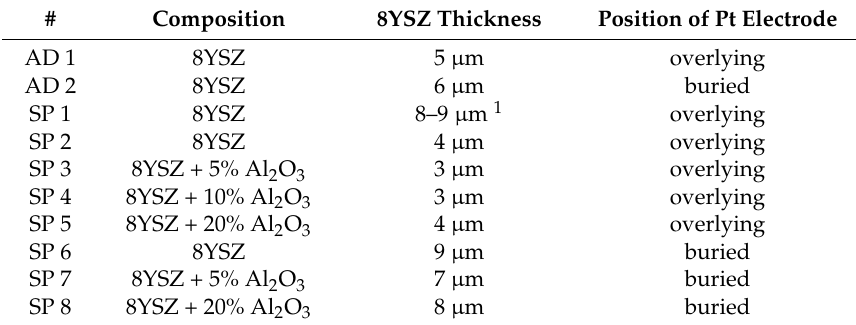
Table 1. Overview of all sensors with aerosol deposited (AD) and screen-printed (SP) 8YSZ electrolytes. # Composition 8YSZ Thickness Position of Pt